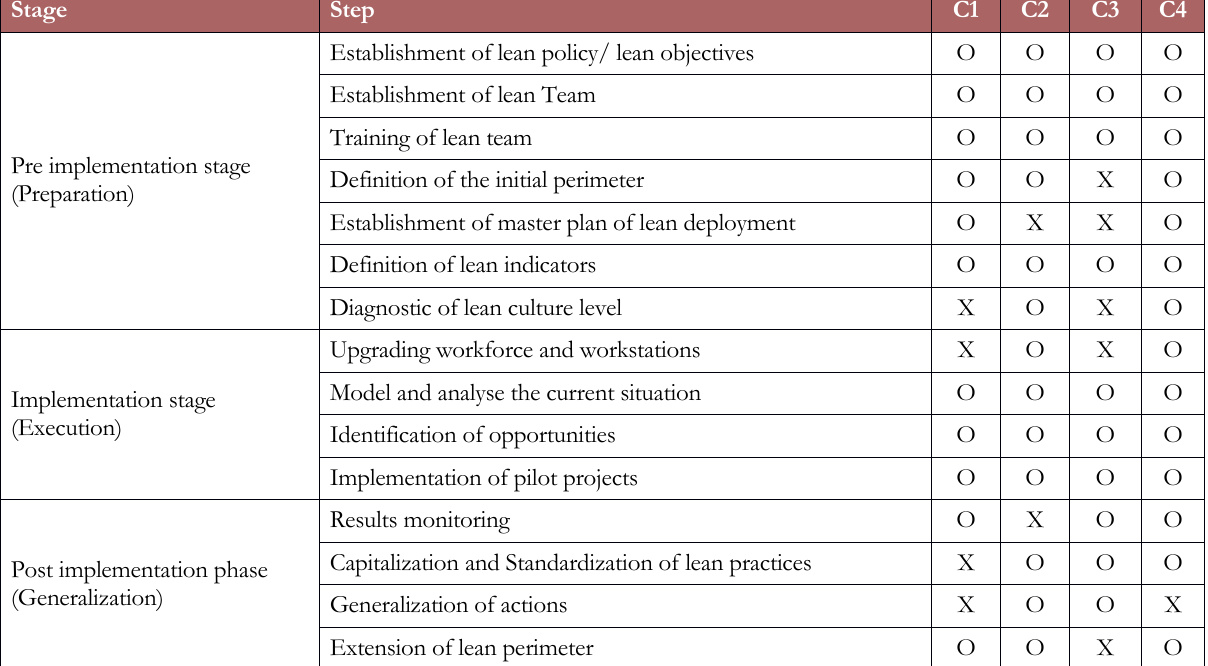
Table 3. Process of lean implementation in SMEs